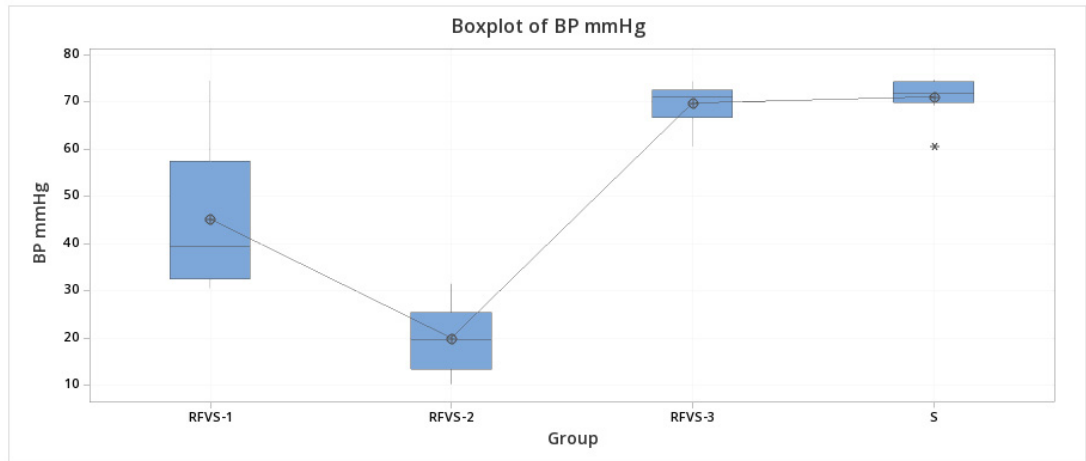
Figure 7. Boxplot of BP test. Mean maximum BP values for each group in Study arm 1. Group S, Stapler; Group RFVS-1, LigaSure 5 mm Dolphin tip; Group RFVS-2, ENSEAL; Group RFVS-3, LigaSure Atlas 10 mm; BP, Burst Pressure). Group HS was not tested because of sealing failure in all samples. RFVS-1 was significantly lower ( p < 0.05) than the RFVS-3 and S groups, but significantly higher than the group RFVS-2, which recorded the significantly lowest values ( p < 0.05). *: